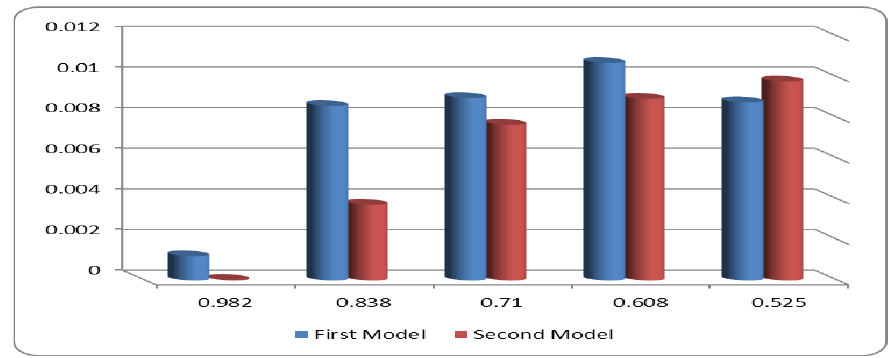
ˆ R for the first and second model at (3, 2). Figure 6. MSEs of ˆ R ˆ R and ˆ R 2 for the first and second model at (3, 2). 1 and 1 2